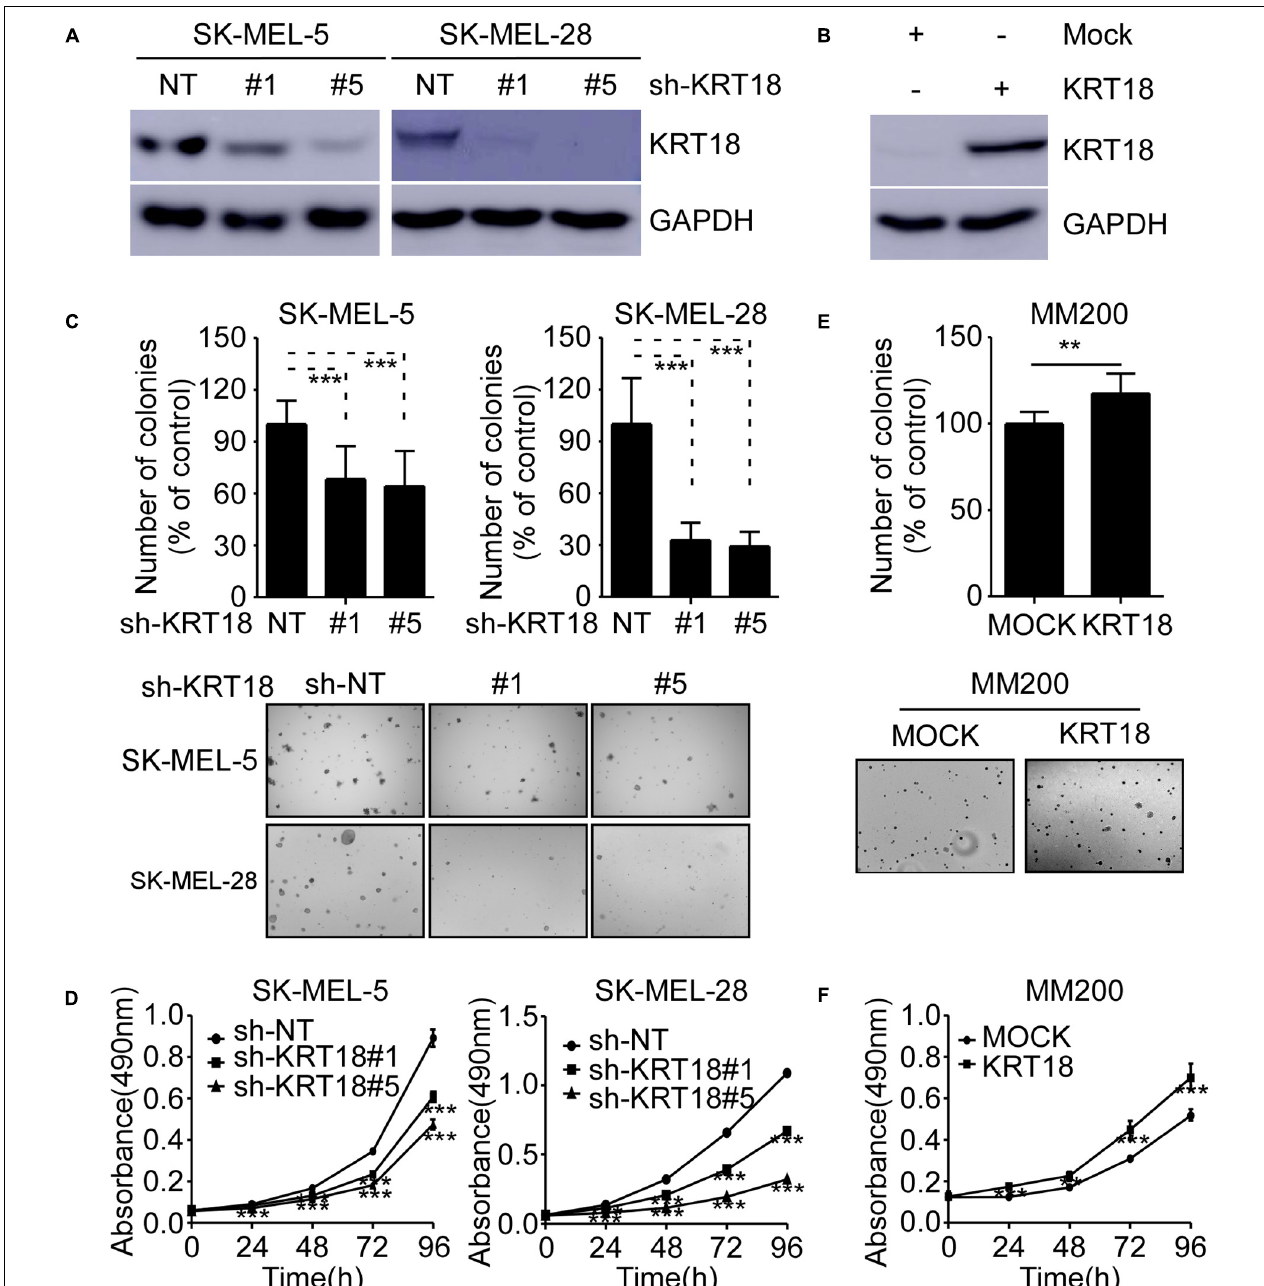
FIGURE 3 | KRT18 promotes melanoma cell growth. (A) Western blot analysis showing KRT18 expression in SK-MEL-5 and SK-MEL-28 cells stably transfected with sh-NT or sh-KRT18. (B) Western blot analysis showing KRT18 expression in MM200 cells overexpressed KRT18. (C) Effect of KRT18 knockdown on anchorage-independent growth of SK-MEL-5 and SK-MEL-28 melanoma cells was evaluated by soft agar assay. Clone count (above); Representative images (below). (D) Effect of KRT18 knockdown on the proliferation of SK-MEL-5 and SK-MEL-28 melanoma cells was evaluated at 0, 24, 48, 72, or 96 h by MTT assay. (E) Effect of KRT18 overexpression on anchorage-independent growth of MM200 melanoma cell was evaluated by soft agar assay. (F) Effect of KRT18 overexpression on the proliferation of MM200 melanoma cells was evaluated at 0, 24, 48, 72, or 96 h by MTT assay. The asterisk (** p < 0.01 and *** p < 0.001) indicates a significant difference compared to the control